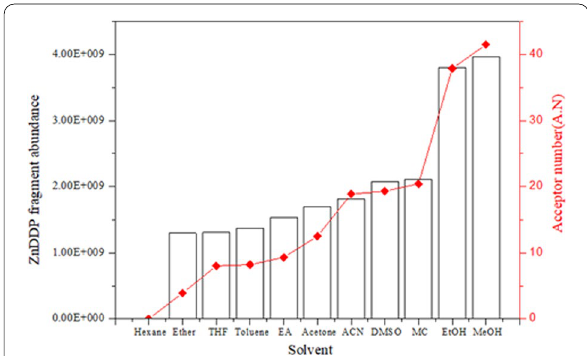
Fig. 3 Molecular ion strength according to the acceptor number of the